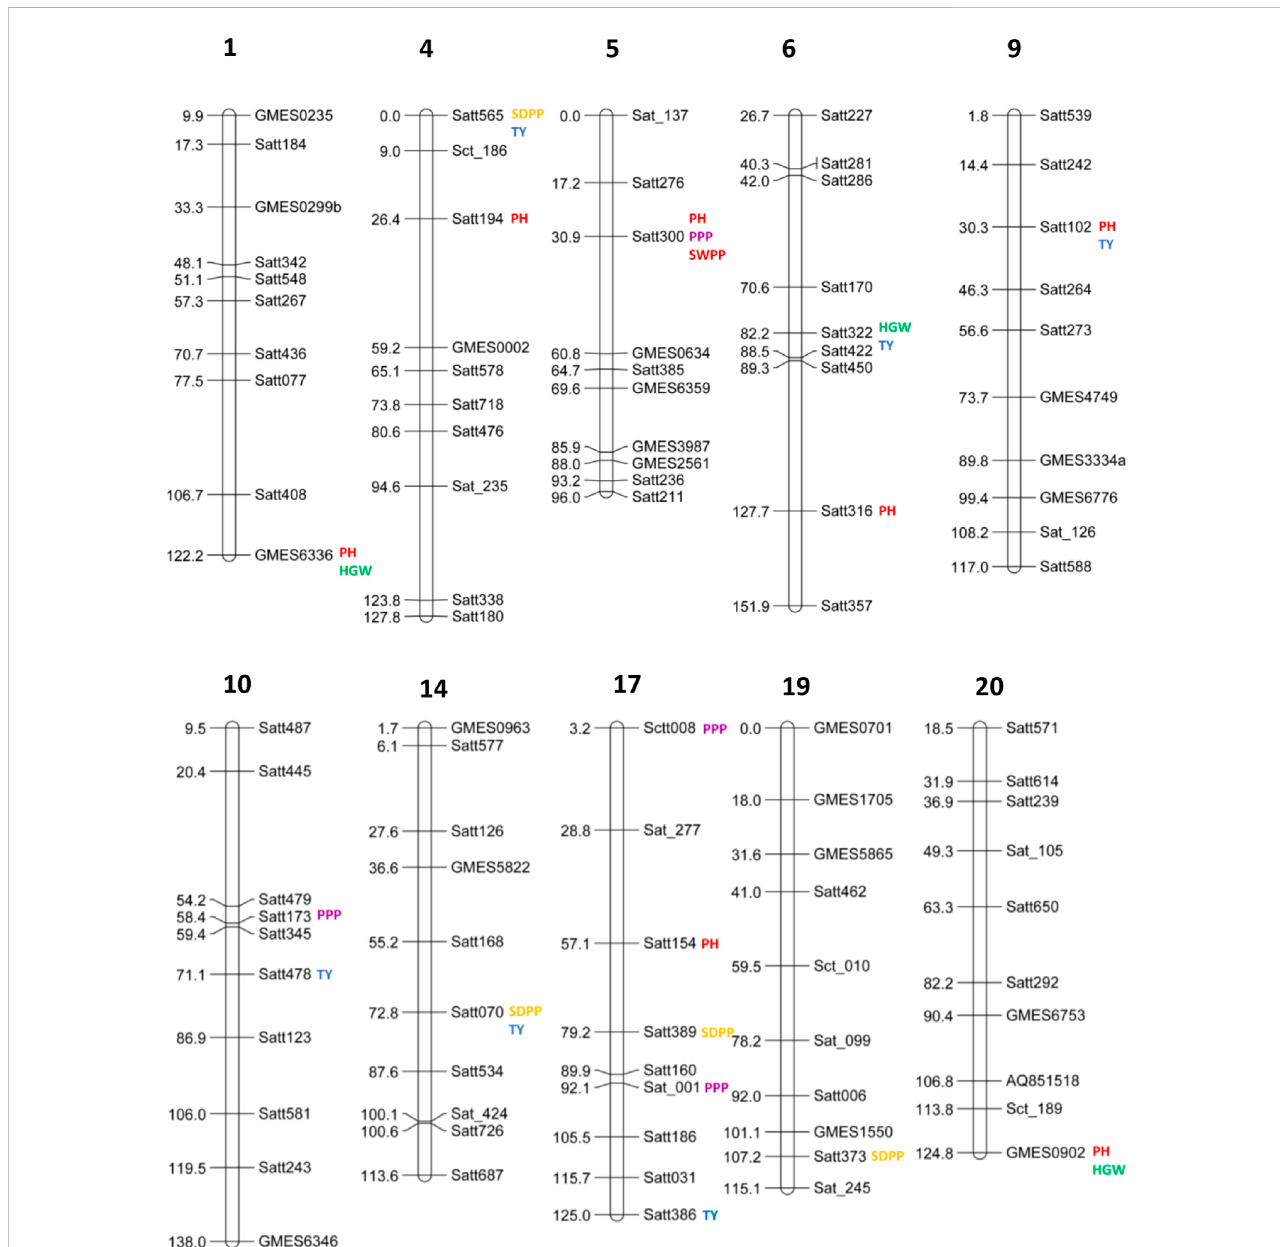
FIGURE 9 Genetic linkage map of soybean using simple sequence repeat (SSR) markers showing the marker positions and estimated map distance in cm on chromosomes 1, 4, 5, 6, 9, 10, 14, 17, 19, and 20. Markers associated with plant height (PH), pods per plant (PPP), seeds per plant (SDPP), seed weight perplant (SWPP), hundred-grain weight (HGW), and total yield (TY) are identi fi ed by colors. Markers that do not show any signi fi cant association with traits are not highlighted with any